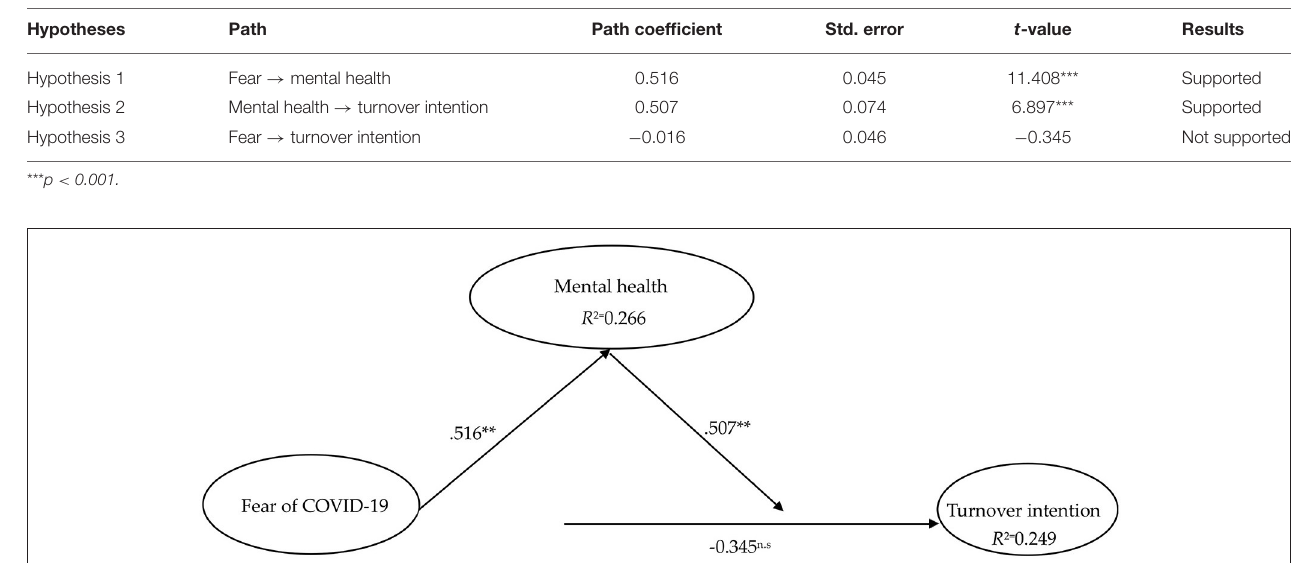
TABLE 6 | Structure model results.